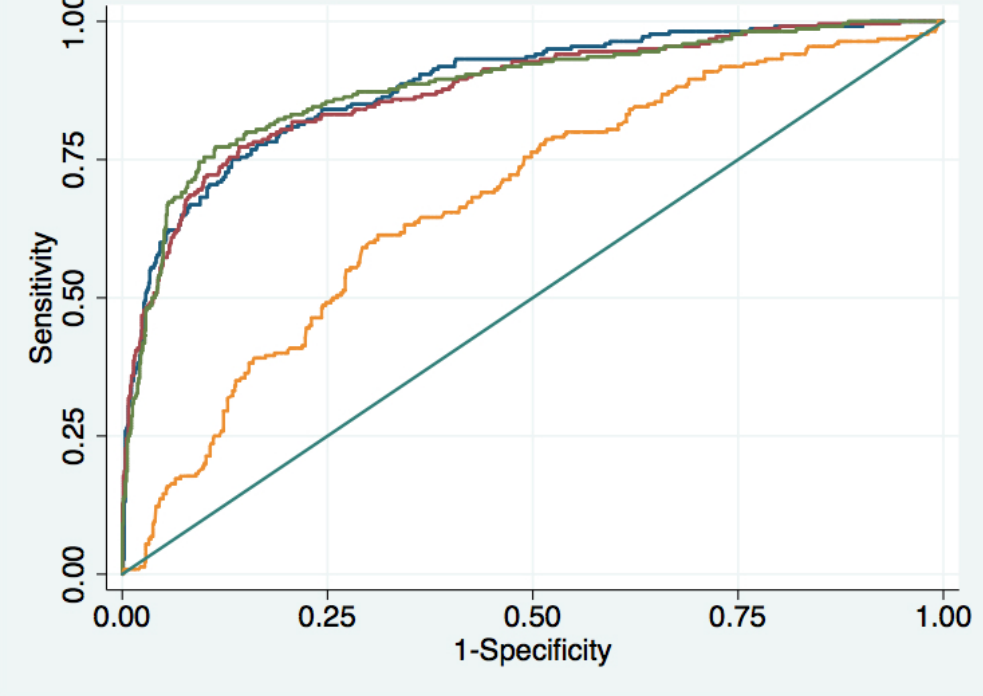
Figure 2. Receiver Operator Characteristic (ROC) curves for models predicting patient reports of fair or poor general health